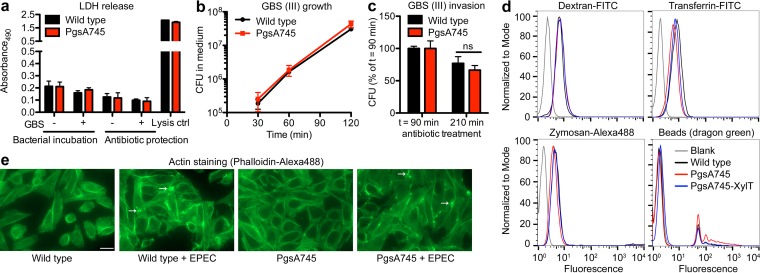
Viability, bacterial growth rates, endocytosis/phagocytosis, and actin relocalization are normal in pgsA745 cells. (a) LDH release was not affected by infection or treatment with antibiotics in pgsA745 cells. Error bars indicate SD; n = 4. (b) Bacterial growth rate in pgsA745 cells was unaffected. Error bars indicate SD; n = 3. (c) Intracellular bacterial growth/survival was unaltered in pgsA745 cells as measured by CFU count after 90 and 210 min of antibiotic protection. Bacterial counts at t = 90 min were set to 100%. Error bars indicate SD; n = 3. (d) Endocytosis and phagocytosis of fluorochrome-labeled dextran, transferrin, zymosan, or beads were unaffected in pgsA745 cells as measured by flow cytometry. (e) Actin relocalization probed using EPEC infection was unaltered in pgsA745 cells. Arrows point to typical actin “pedestals” induced by EPEC. Scale bar = 20 μm.